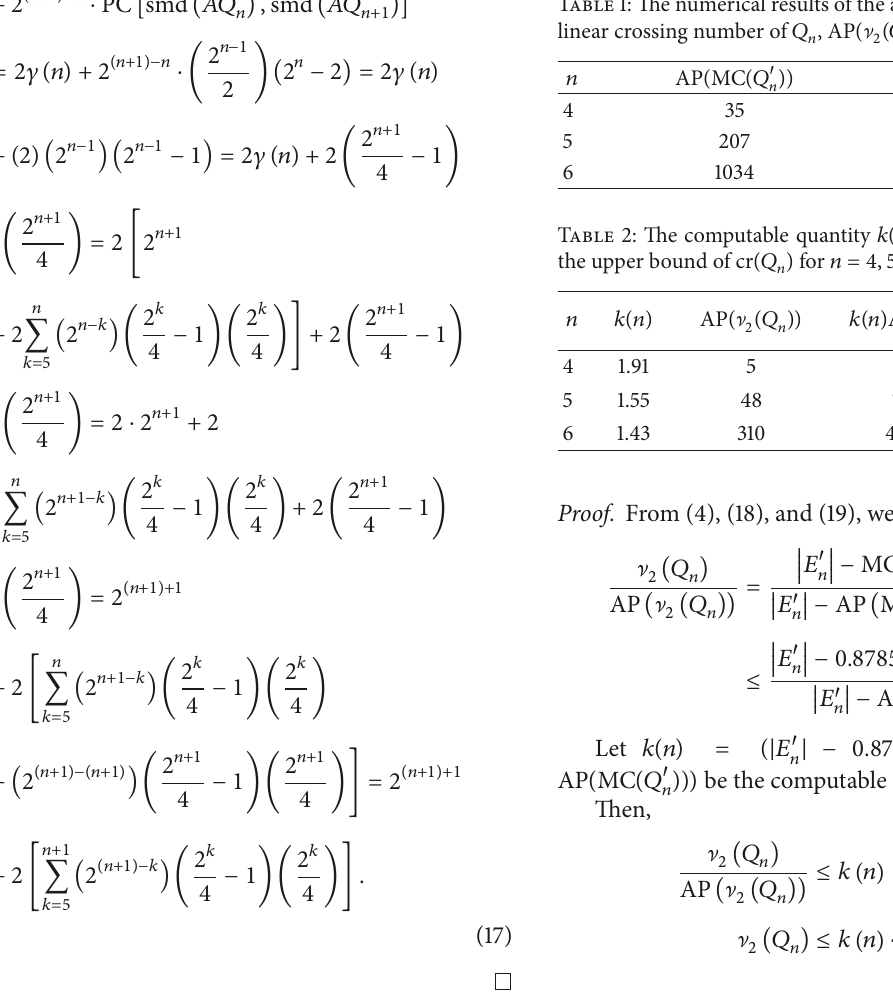
Table 1: The numerical results of the approximation of 2-page fixed